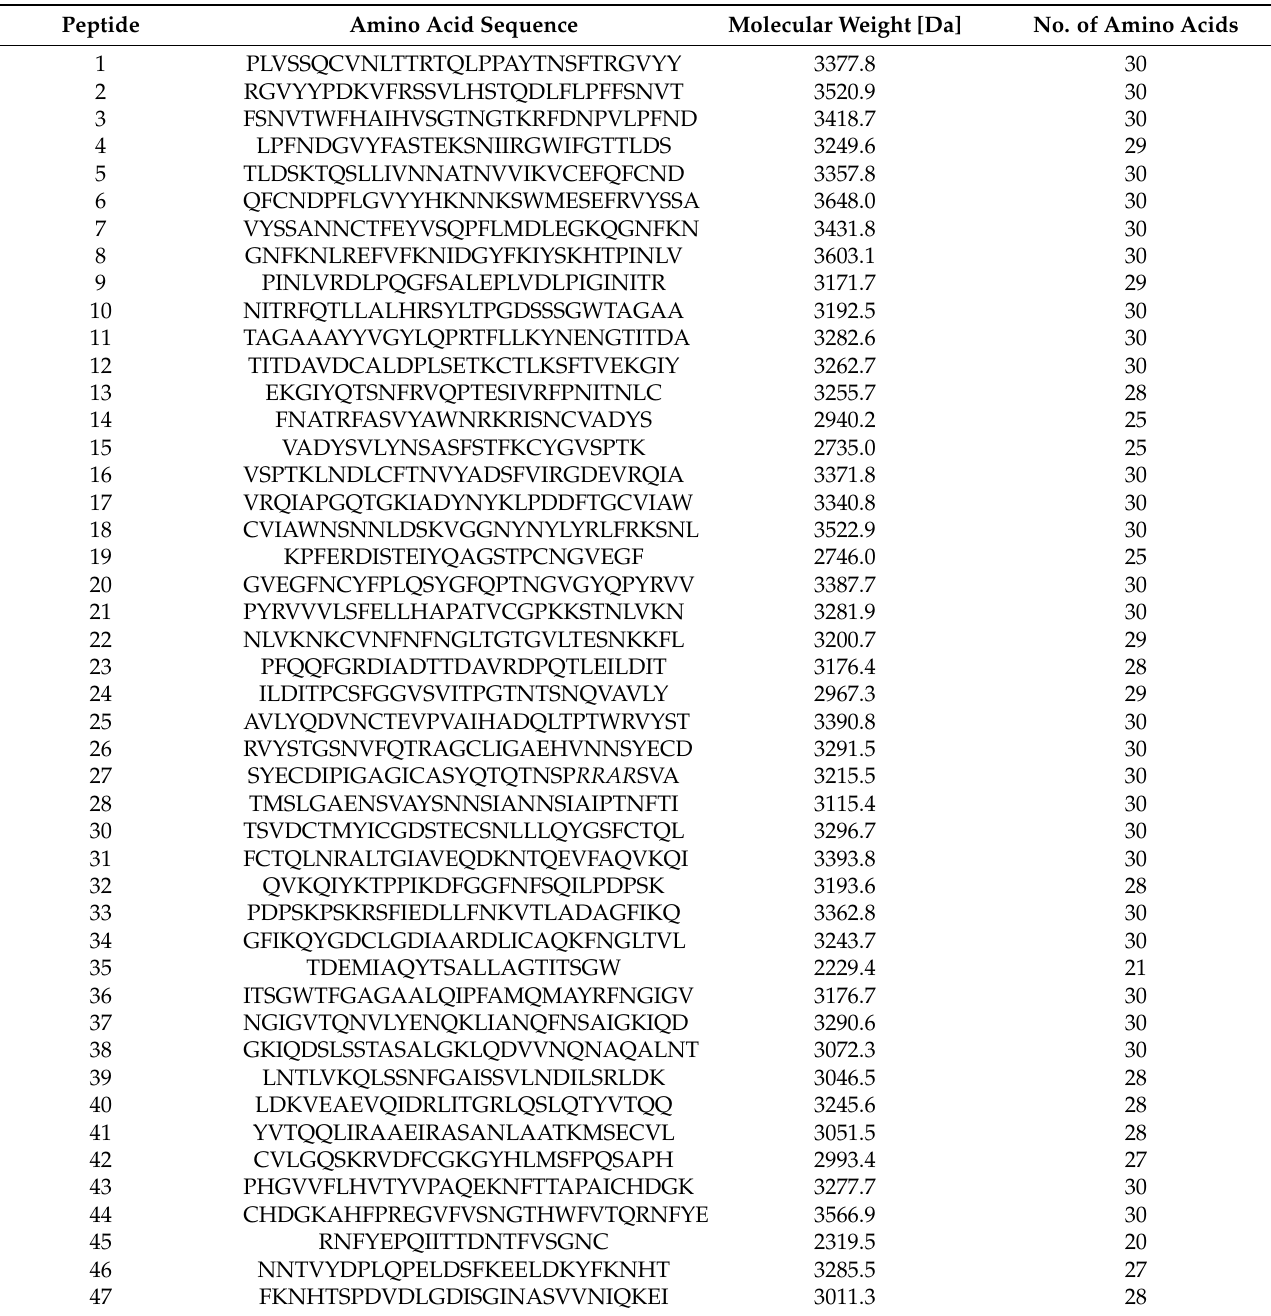
Table 3. Synthetic SARS-CoV-2 spike protein-derived peptides §